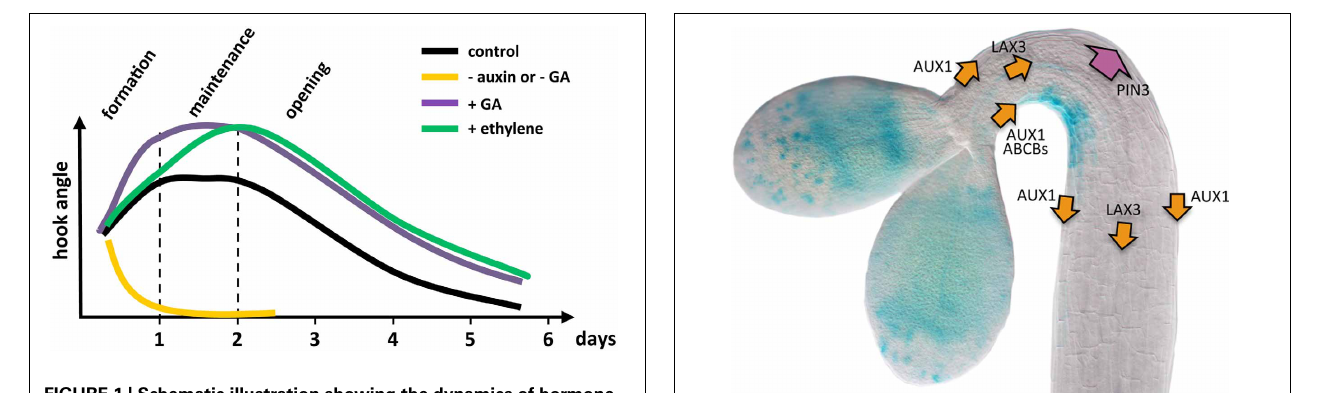
FIGURE 1 | Schematic illustration showing the dynamics of hormone actions in apical hook development in Arabidopsis . The - auxin was produced by treating with the auxin transport inhibitor naphthylphthalamic acid (NPA); - GA, by GA biosynthesis inhibitor paclobutrazol; and + ethylene, by adding the immediate ethylene precursor, ACC. The + GA shows the GA action constitutively revealed by the use of a dellaKO mutant.